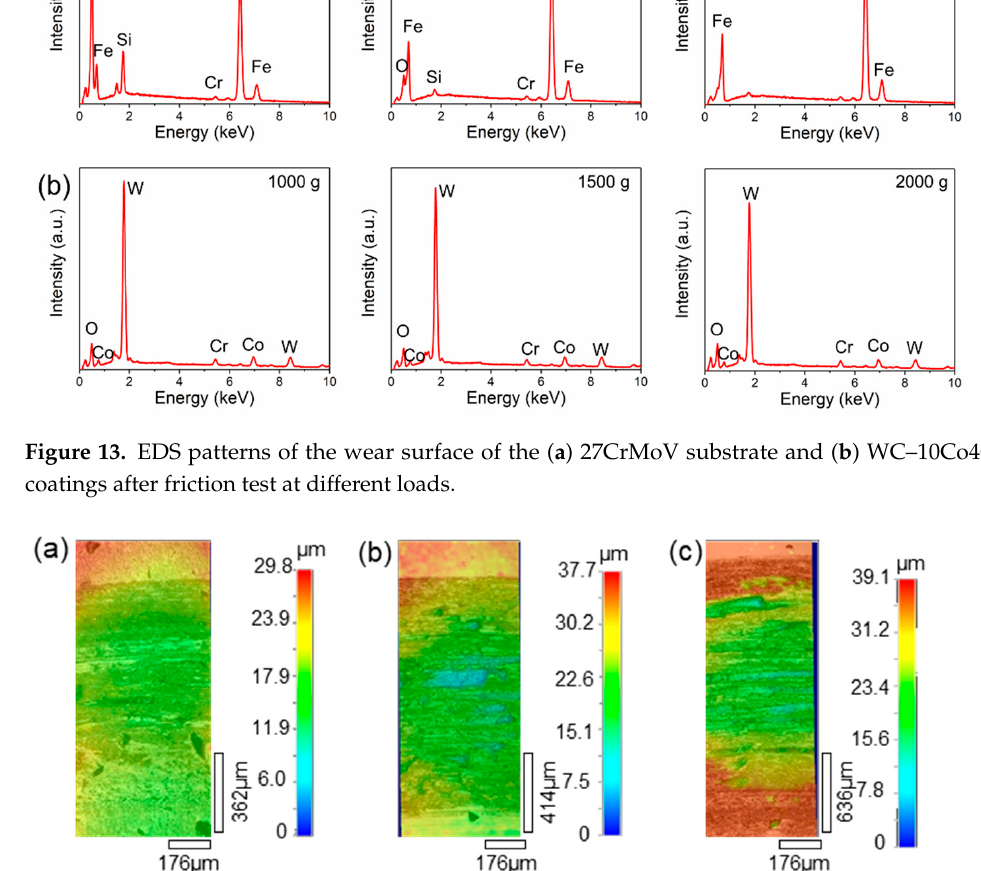
Figure 13. EDS patterns of the wear surface of the ( a ) 27CrMoV substrate and ( b ) WC–10Co4Cr coatings after friction test at different loads.